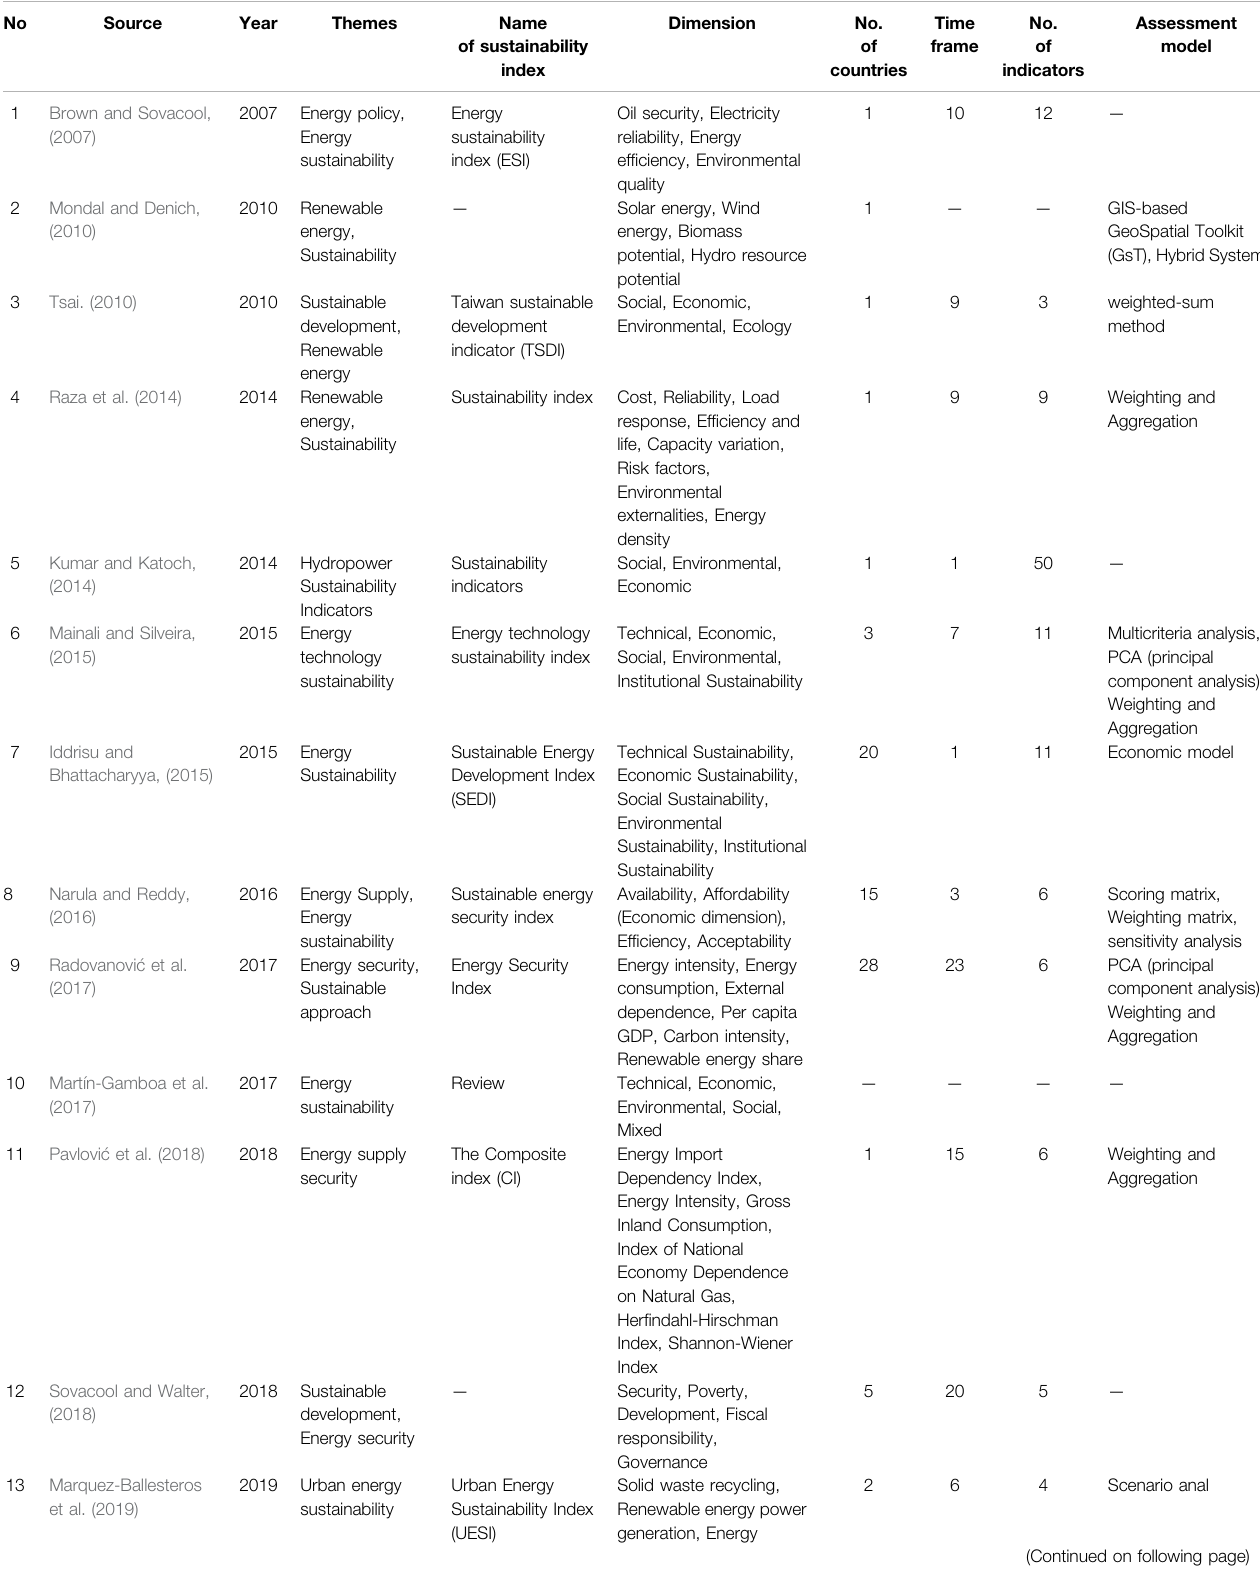
TABLE 1 | Selected research on energy sustainability comprehensive